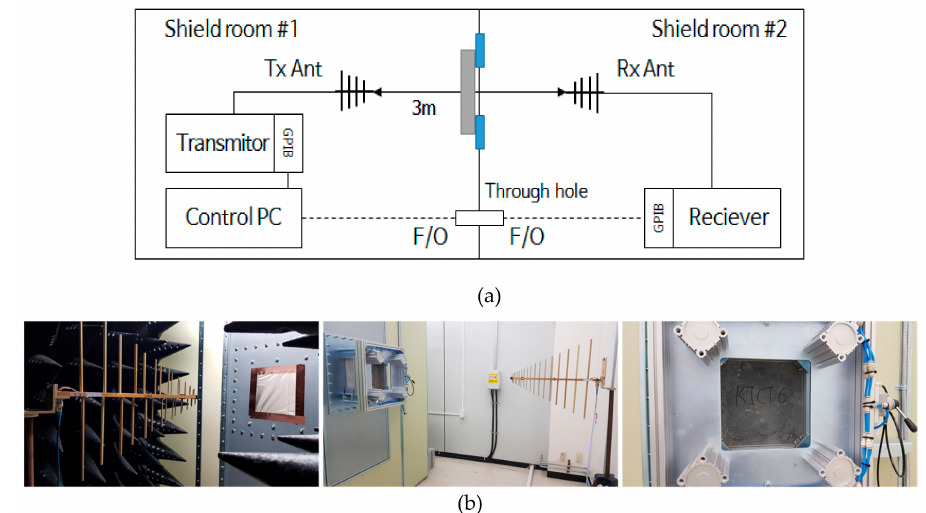
Figure 1. Shielding e ff ectiveness measurement system. ( a ) System configuration, ( b ) Tx (Transmission) antenna, Rx (Receiving) antenna, and sample installation.